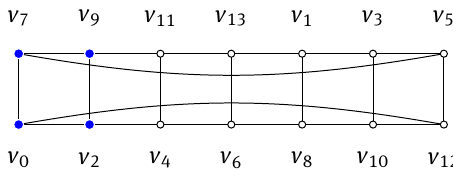
Figure 2: The graph C 14 (2, 7) ∼ = K 2 (cid:3) C 7 (see Section 4) with a zero forcing set.